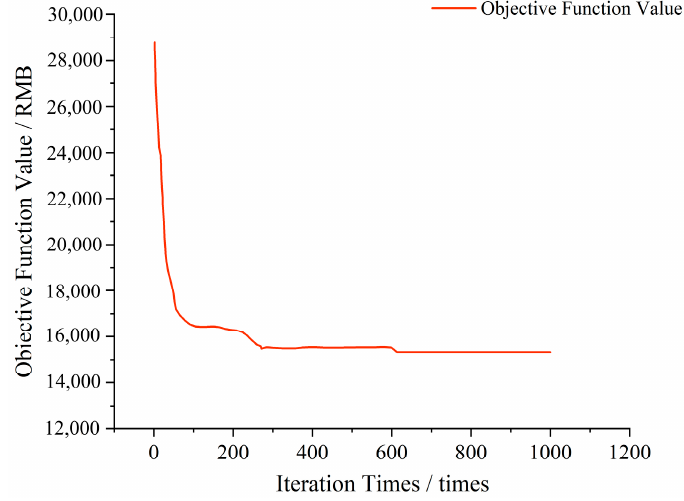
Figure 7. Convergence diagram of objective function.